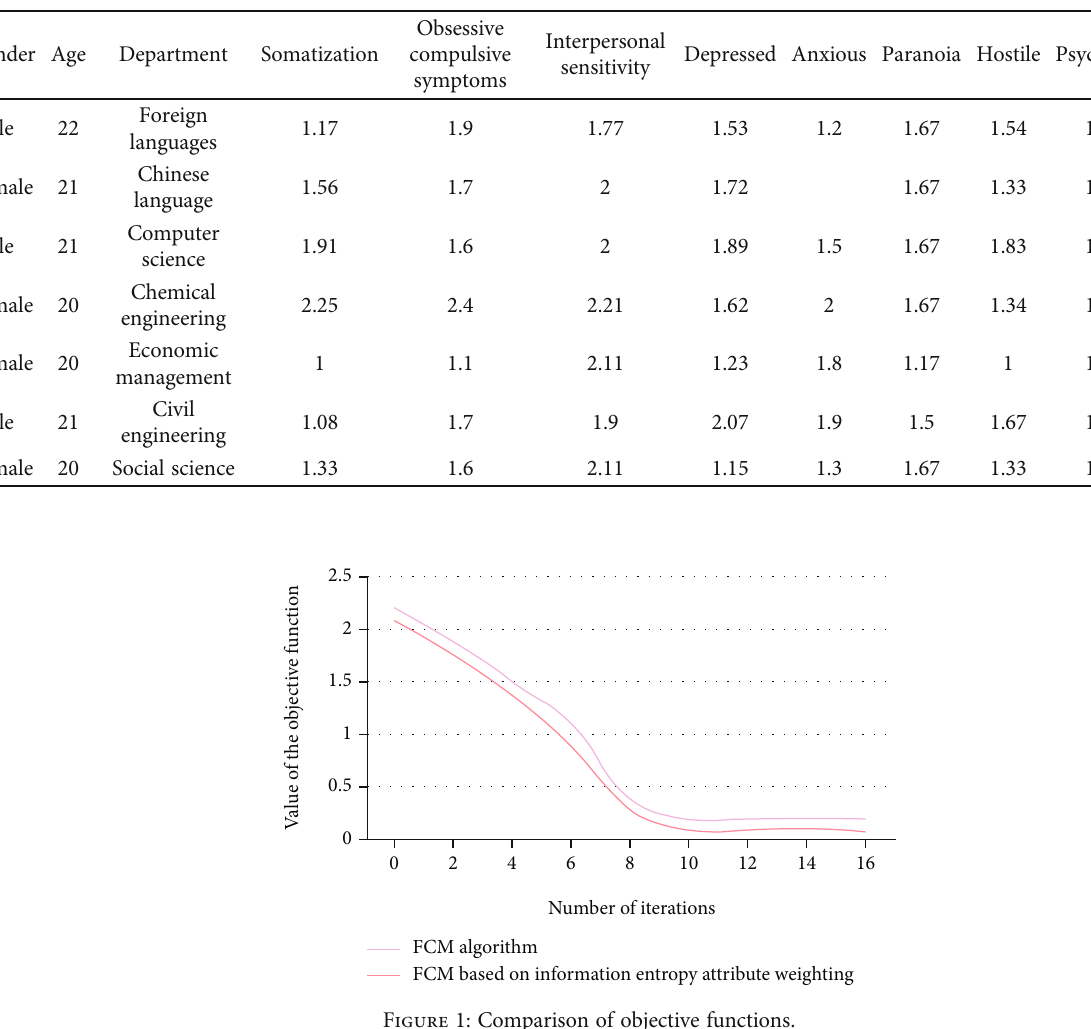
Table 2: Data table of mental health database for college students.